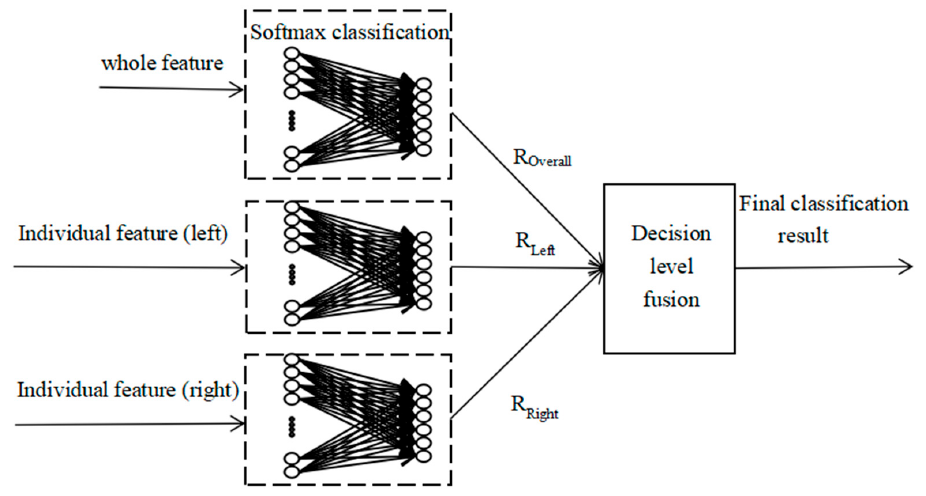
Figure 7. Human body interactive video recognition based on decision level fusion.